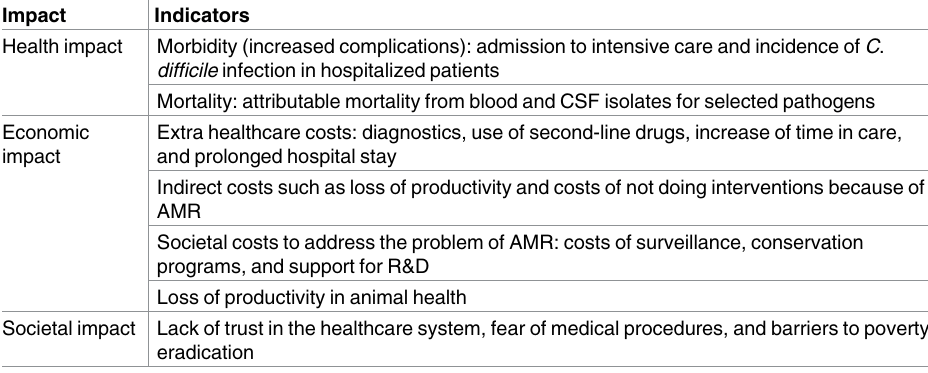
Table 3. Outcomes of AMR: Potential measurements of